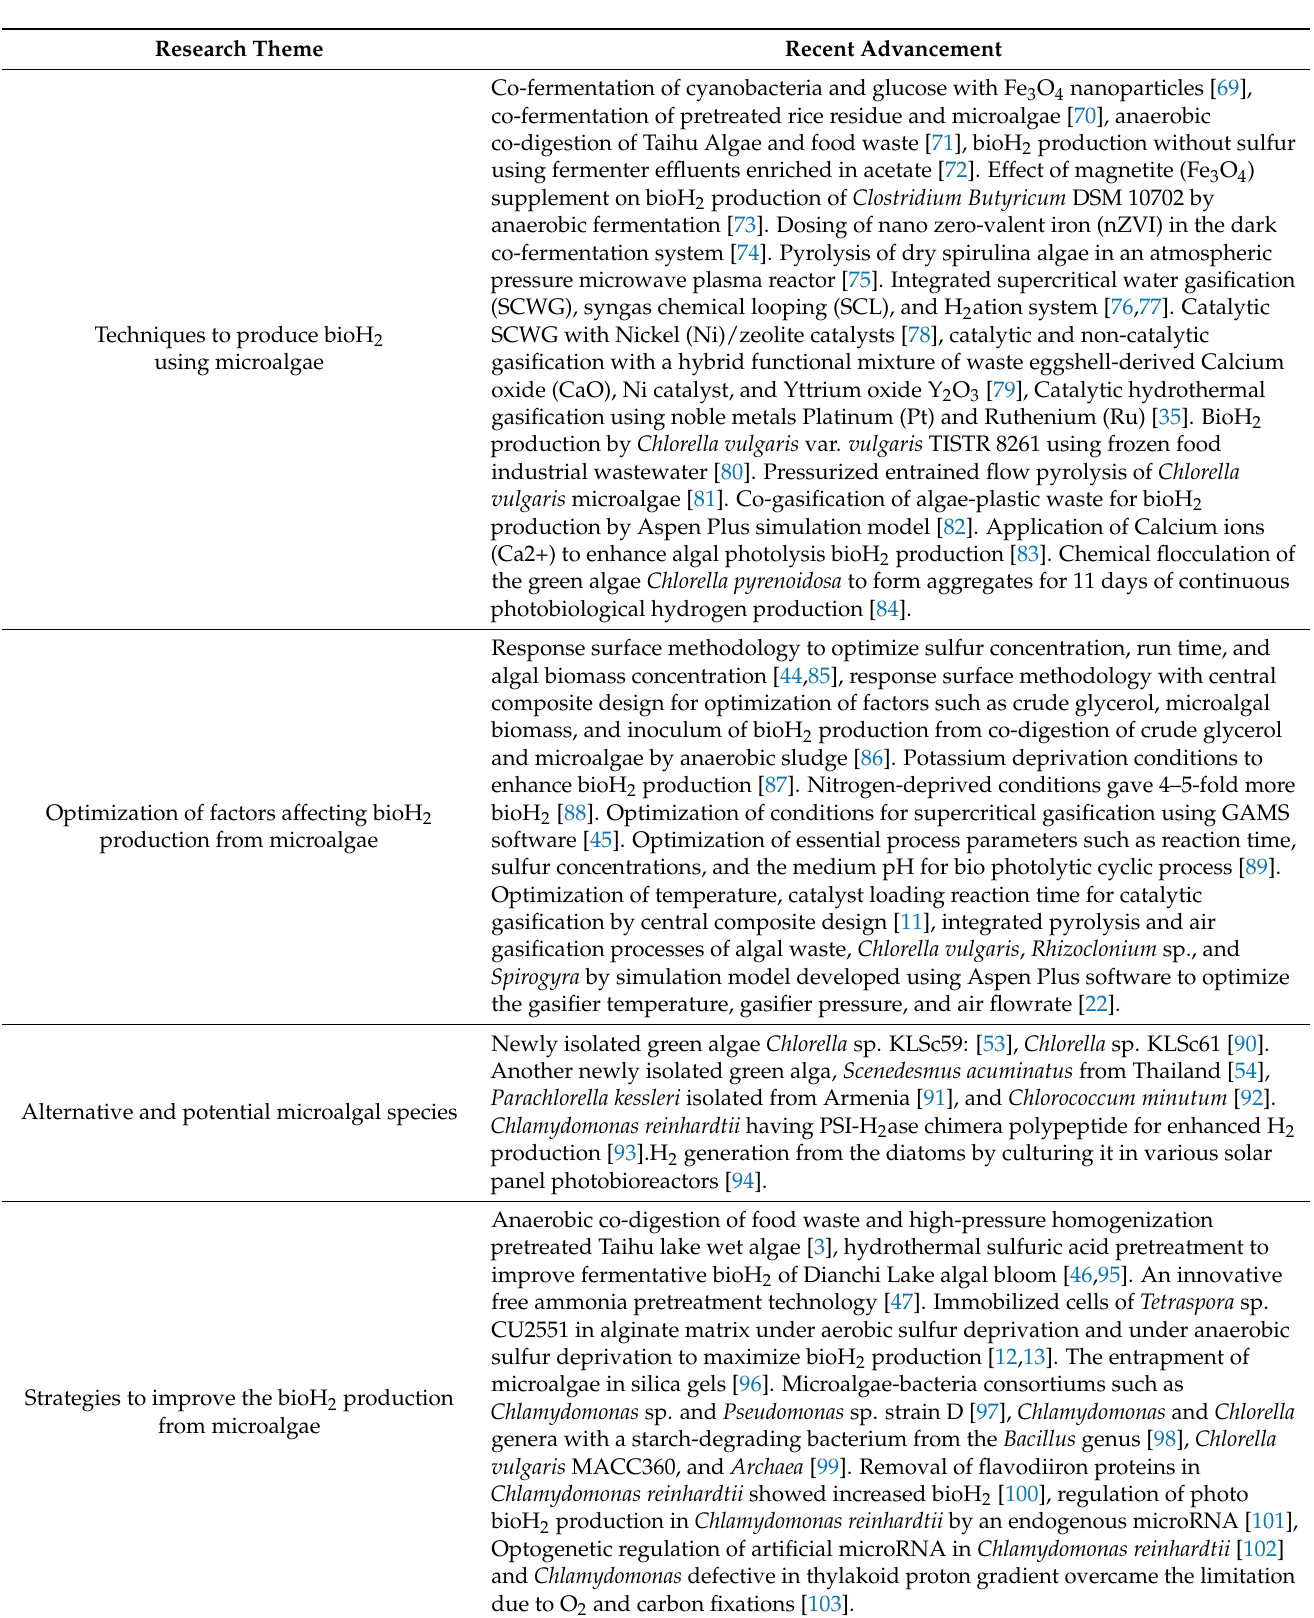
Table 6. Research themes and recent advancements in the